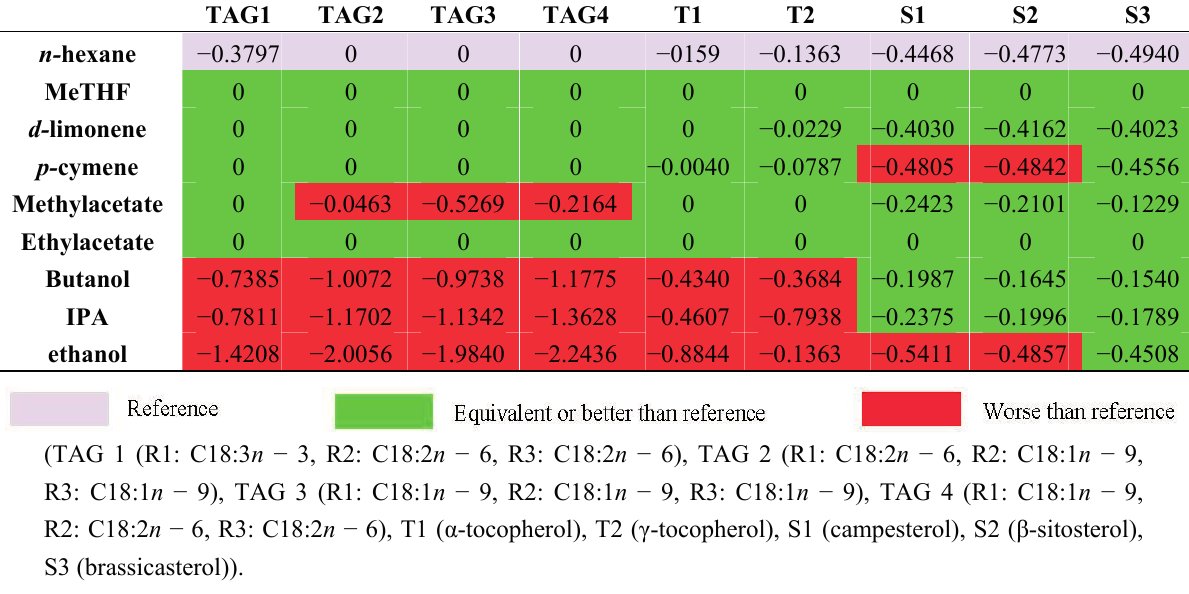
Table 3. COSMO-RS assisted solvent selection: relative solubility (log (x-solub)) of major compounds of rapeseed oil in several solvents at 55